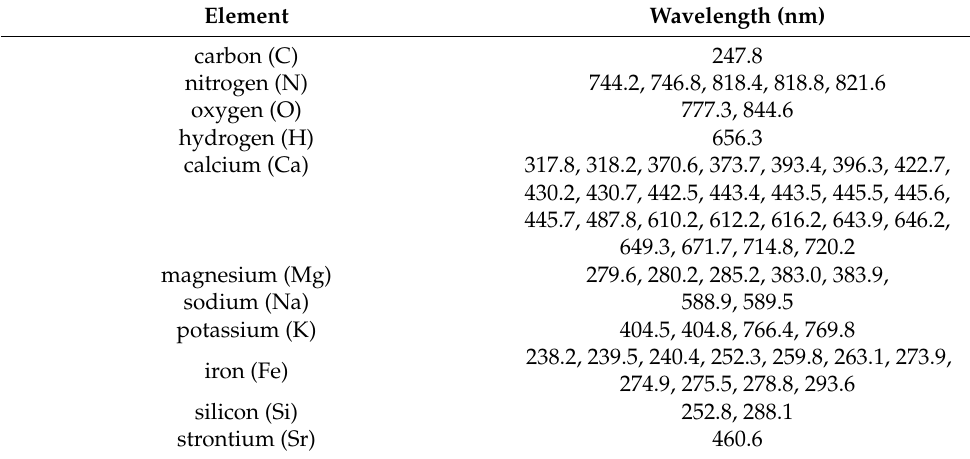
Table 1. List of identified elements in t. dioica samples.